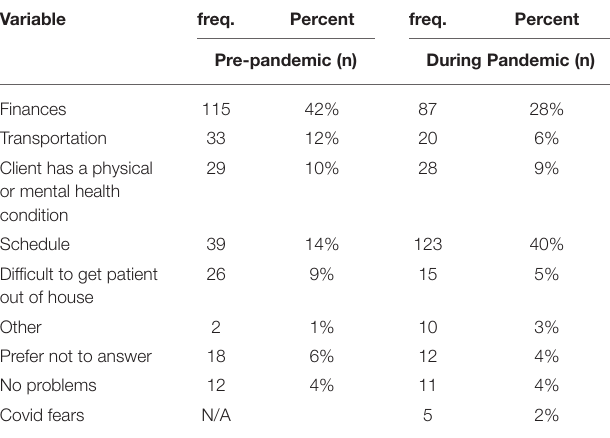
TABLE 1 | Demographics for 205 clients of a low-cost veterinary clinic in Worcester, MA. Variable number ( n )